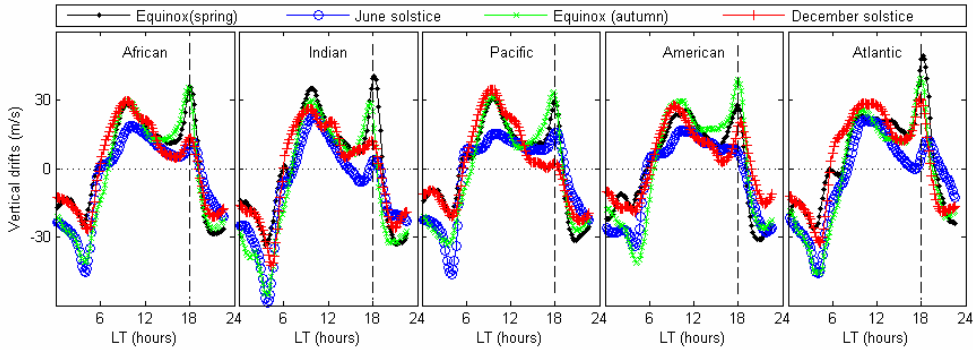
Figure 1. Seasonal variation of local time (LT) averaged vertical drifts at five longitude sectors representative of the African ( ∼ 0–45 ◦ ) , Indian ( ∼ 45–100 ◦ ) , Pacific ( ∼ 100–240 ◦ ) , American ( ∼ 240–310 ◦ ) and Atlantic ( ∼ 310–360 ◦ ) regions during the period year 2000-2002.